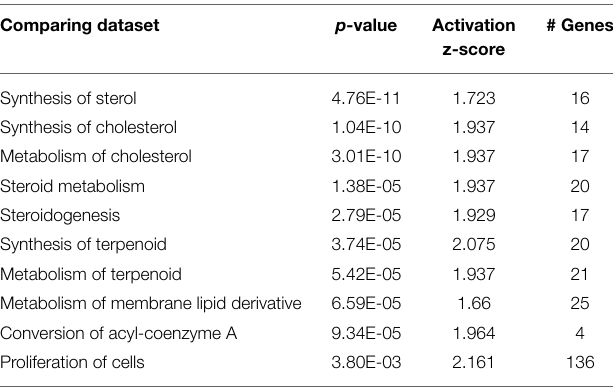
TABLE 4 | Comparison of non-hair cell dataset with known expression changes in biosynthesis and proliferation datasets. Comparing